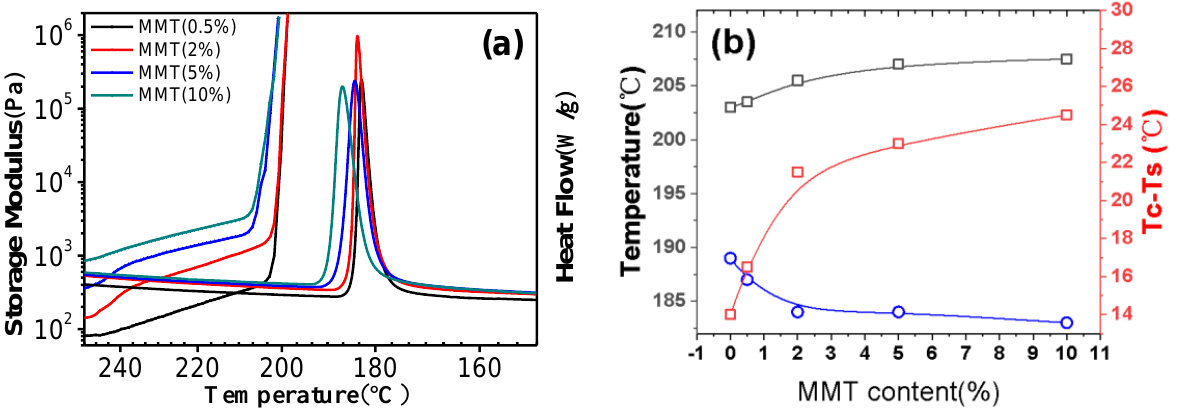
Figure 3. ( a ) The storage modulus and calorimetry results of nylon 6/montmorillonite composites with different montmorillonite loadings during cooling. ( b ) Solidification temperature(red symbols), crystallization temperature(black symbols) and their difference(blue symbols) of neat nylon 6 and nylon 6/MMT composites with different MMT content.